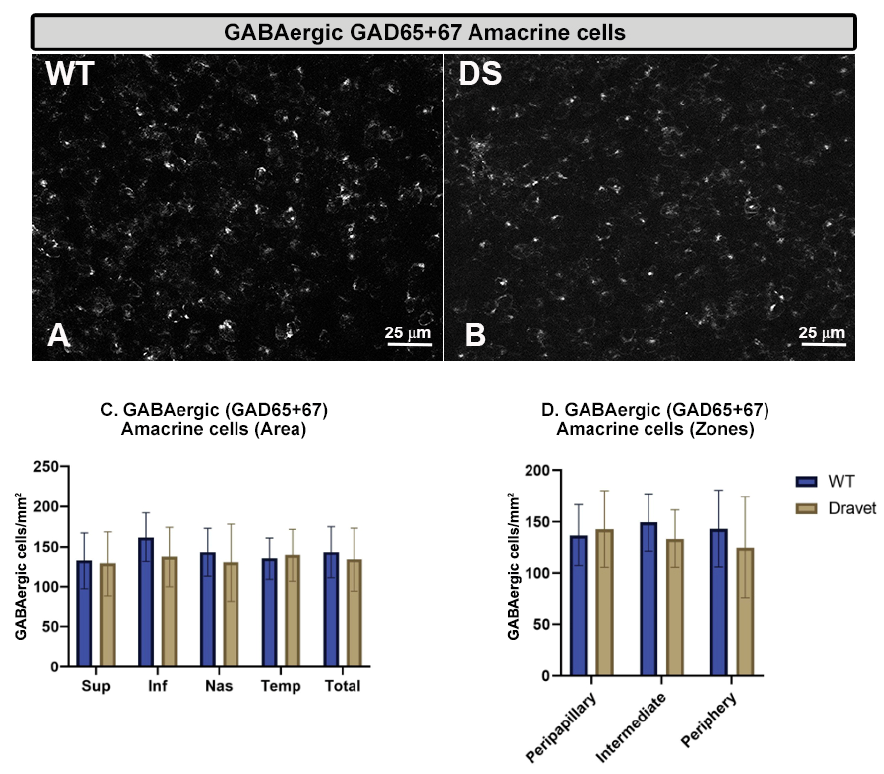
Figure 5. Retinal ganglion cell (RGC) number. ( A , B ): retinal whole-mounts labeled with anti-Brn3a at 20× magnification in WT animals ( A ) and in Dravet syndrome (DS) animals ( B ). ( C , D ): number of Brn3a + RGCs per retinal area 0.1502 mm 2 by total retina and areas ( C ) and by zones ( D ). Two-way ANOVA. Data expressed as mean value (±SD). Number of retinas used in the experiment: WT animals n = 6, DS animals n = 6. Sup: superior; Inf: inferior; Nas: nasal; Temp: temporal.